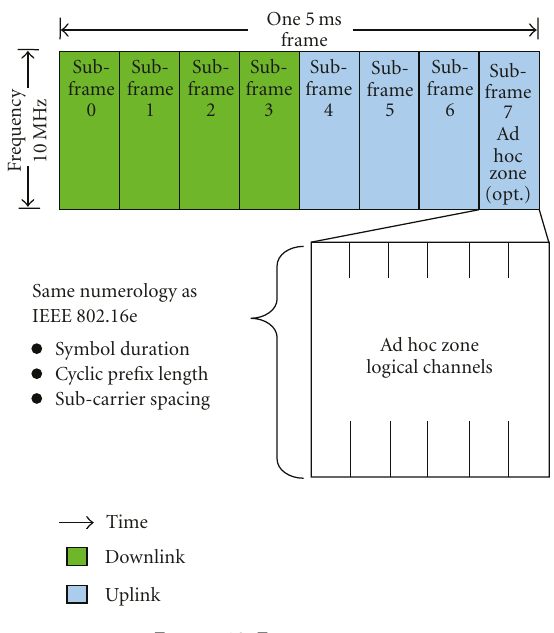
Figure 10: Frame